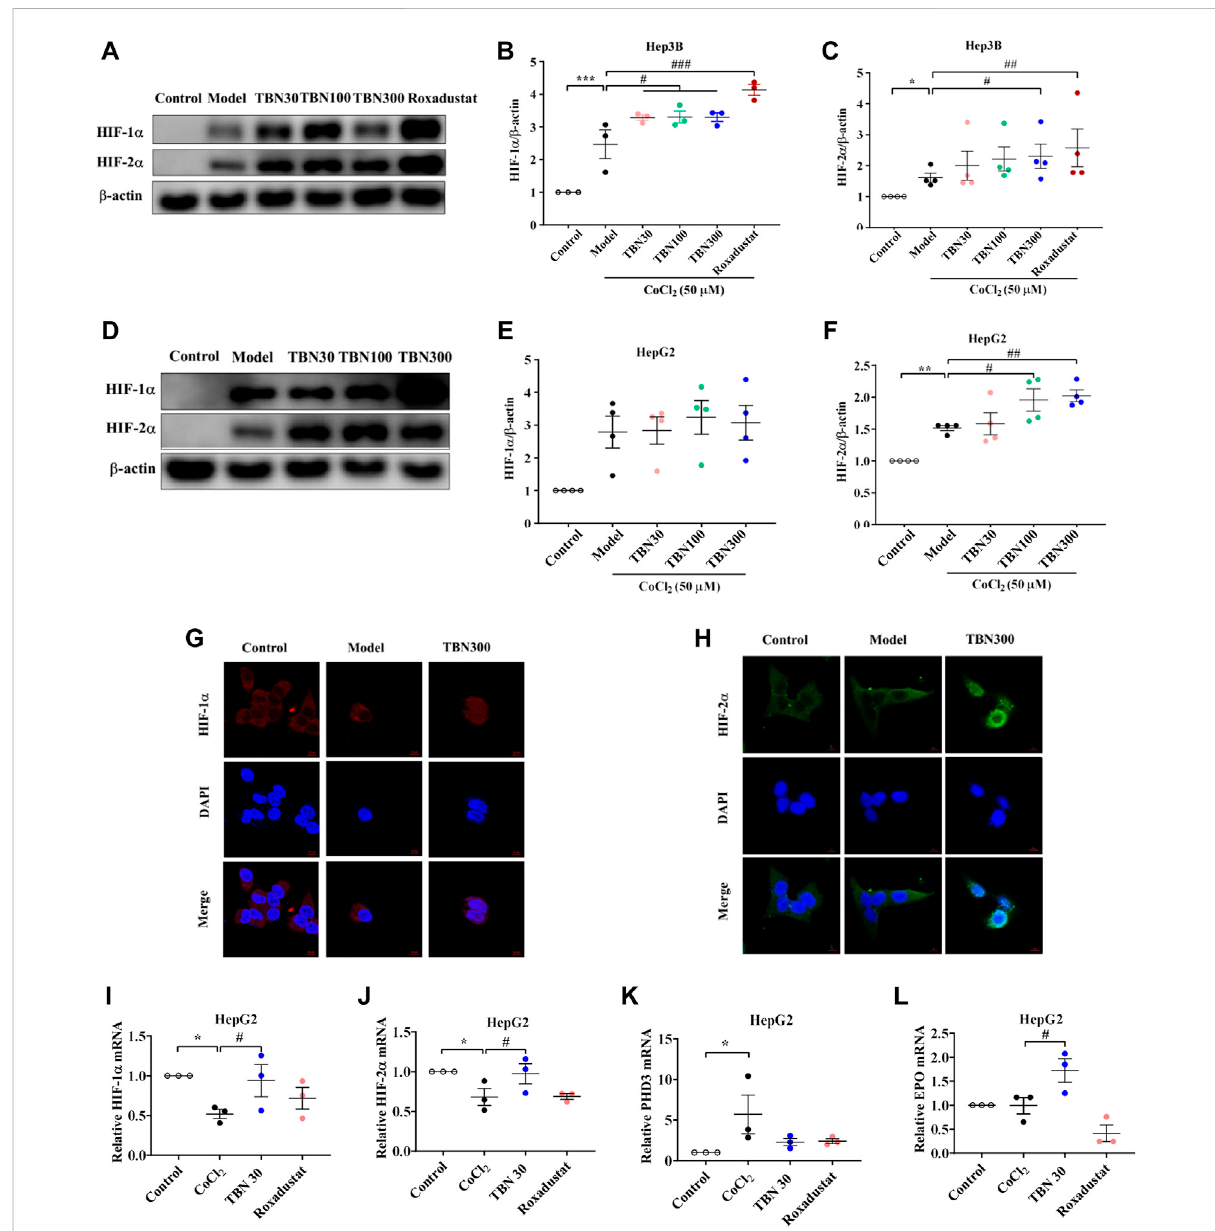
TBNincreasestheexpressionofHIF-1 α andHIF-2 α inCoCl 2 -inducedHep3BandHepG2cells. (A – C) EffectsofTBNonexpressionofHIF-1 α and HIF-2 α in CoCl 2 -induced Hep3B cells. (D – F) Representative western blots of HIF-1 α and HIF-2 α in HepG2 cells. (G,H) HIF-1 α and HIF-2 α